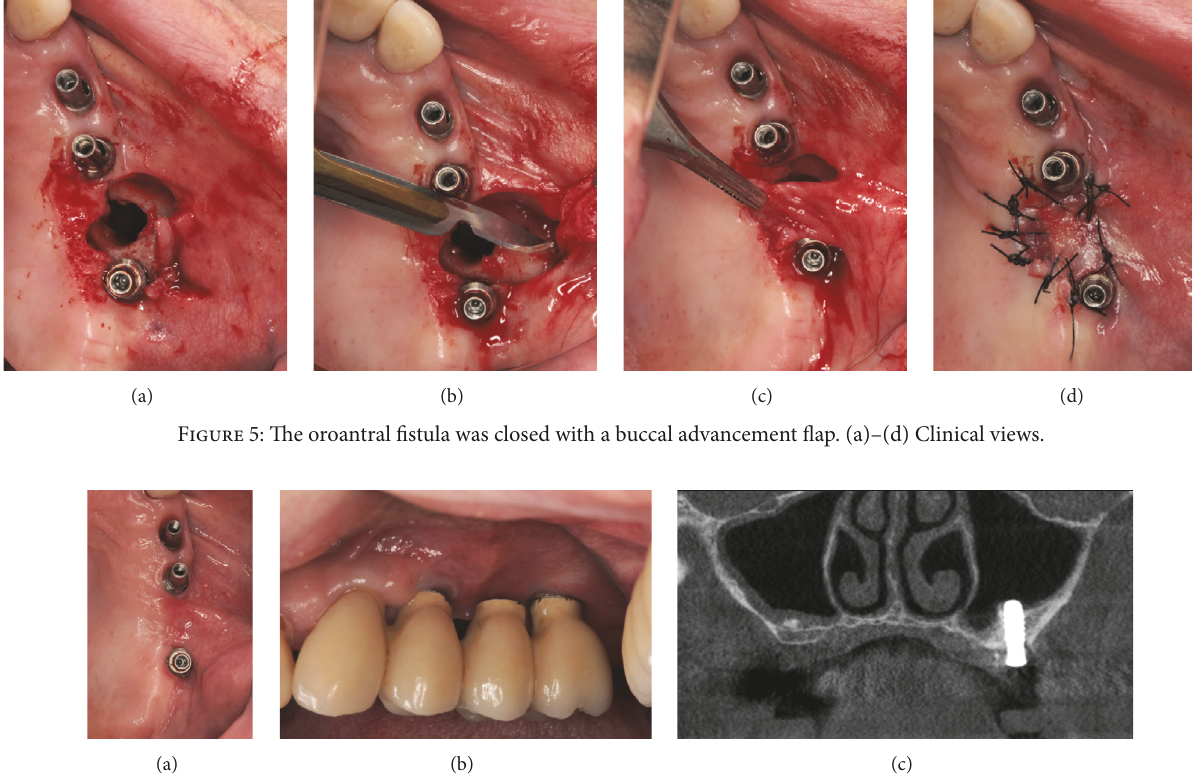
Figure 6: Two months after the closure of OAF. (a)-(b) Clinical views. The oroantral fistula remained successfully closed. (c) Cone-beam computed tomography image. The left sinus was totally healed.